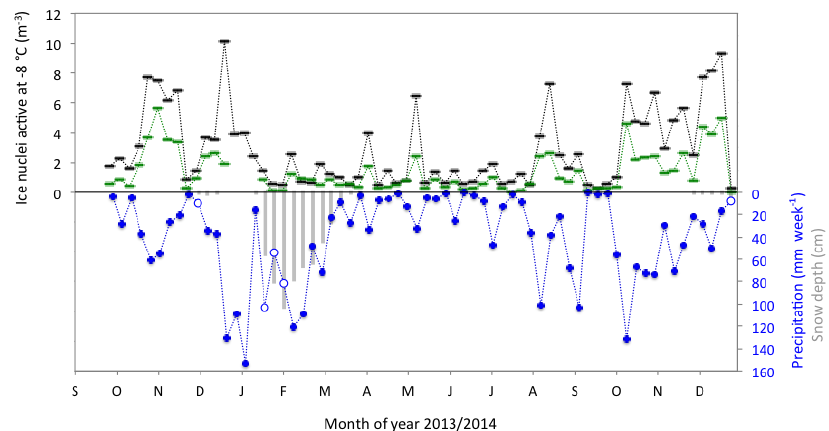
Figure 2. Time course of INP − 8 in the PM 10 (black) and PM 2 . 5 (green) particle size fractions. Peaks in INP − 8 largely mirror peaks in precipitation (blue is inverse scale to mirror precipitation values on the horizontal axis). Snow (open circles) or small amounts of rain are accompanied by very small numbers of INP- 8 in the same week. Significant amounts of snow on the ground (grey bars) seem to attenuate the increase in INP − 8 with intense rainfall. Total amount of precipitation in 2014 was 2077mm (entire period shown: 2640mm). Precipitation and snow cover data are the averages of three stations operated by the Norwegian Meteorological Institute in the municipality of